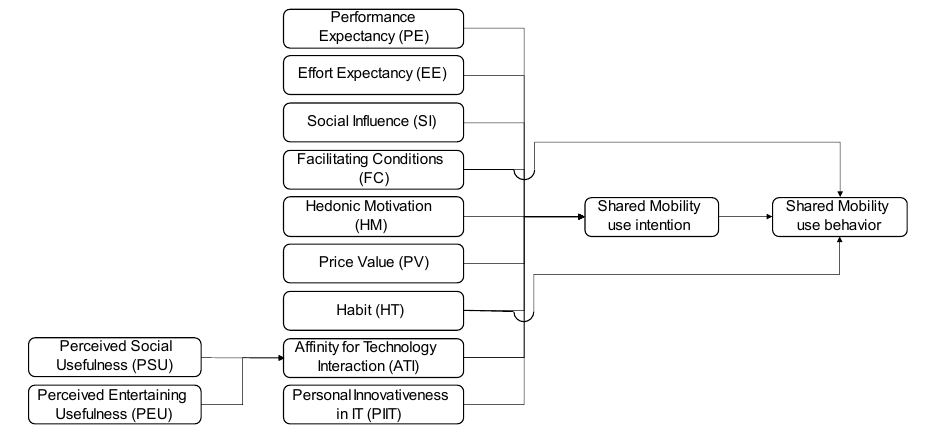
Figure 2. Survey Model.